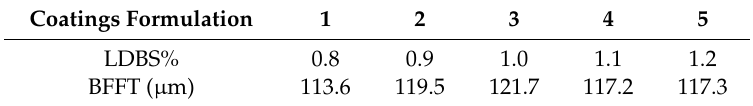
Table 5. Further screening for the optimal amount of LDBS added to the